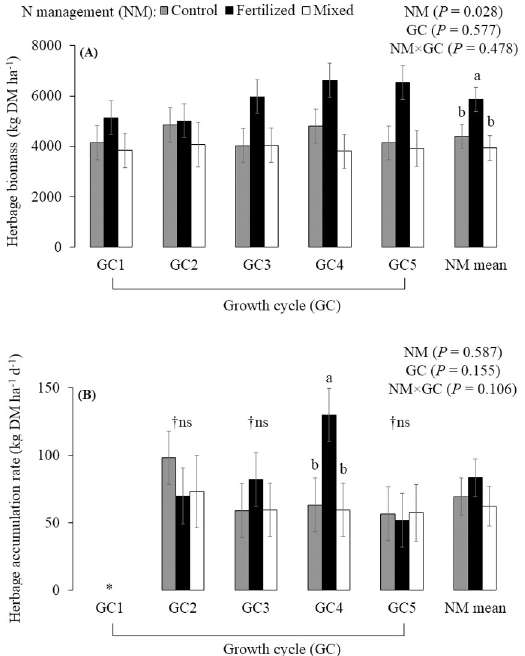
Fig 3. Herbage biomass (A) and herbage accumulation rate (B) of palisadegrass under three nitrogen management strategies (NM) for five growth cycles (mean ± SE bars). Control: palisadegrass without N fertilizer or legume; Fertilized: palisadegrass fertilized with 150 kg N ha -1 year -1 ; and Mixed: palisadegrass mixed with forage peanut and no N fertilizer. � Growth cycle 1 (GC1) was not evaluated, because herbage was not collected prior to staging in September. †Non-significant. Data are means across 2 years, and 4 replicates (n = 8). Means sharing the same letter are not different, according to the PDIFF procedure by LSD test ( P � 0.1).